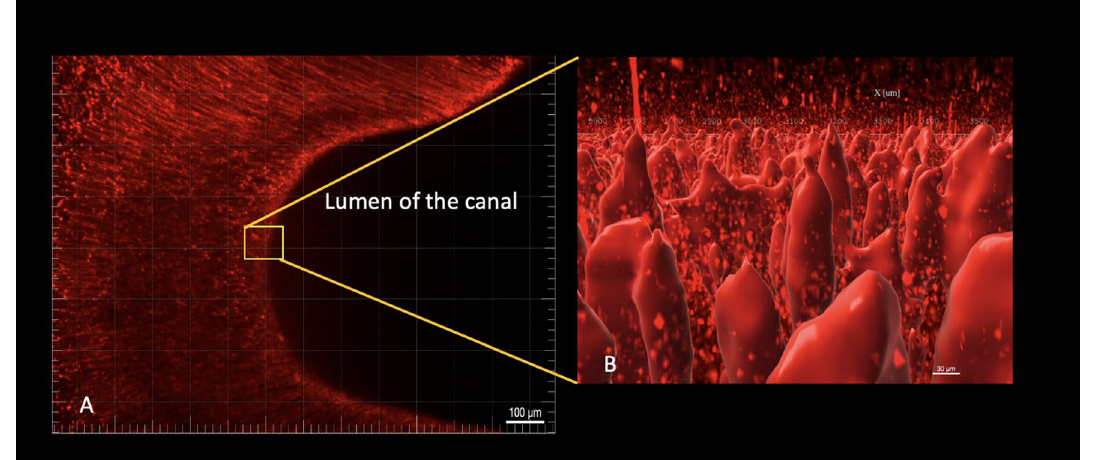
Figure 2. Fluorescent LPS-dentin infection model illustration: ( A ) Fluorescent LPS, cervical third of the root, Z, 10 ×; ( B ) 3D-reconstruction (Fluorescent LPS in the cervical third of the root, Z, 10